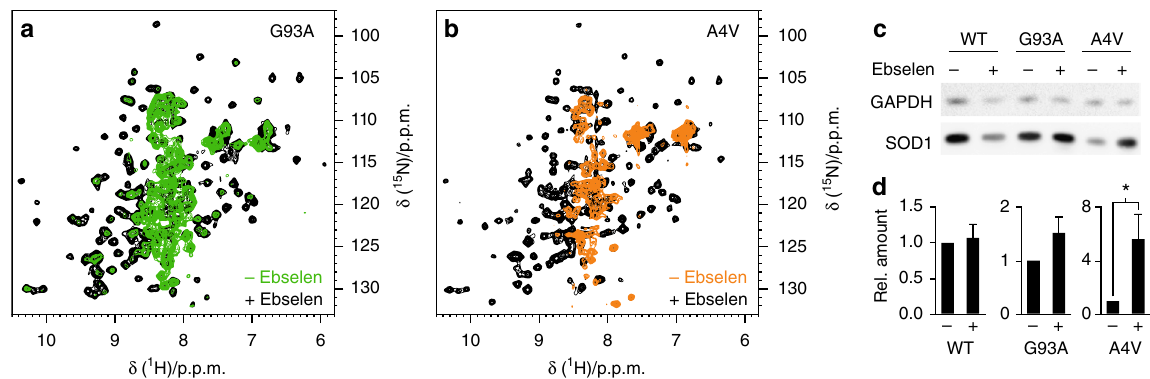
Fig. 5 Ebselen stabilizes ALS mutant SOD1 in living cells. a Overlay of 1 H- 15 N NMR spectra acquired on human cells expressing [U- 15 N] labelled SOD1 ALS mutants G93A ( a ) and A4V ( b ) in the absence (green/orange) and in the presence (black) of ebselen in the external medium. NMR signals clustered in the region around 8.3 p.p.m. ( 1 H) are characteristic of unstructured SOD1 species. c Western blot analysis of cell lysates expressing wild-type and mutant SOD1 in the absence and in the presence of ebselen. Original image Supplementary Fig. 11. d Expression levels of wild-type and mutant SOD1 in cell samples treated with ebselen relative to the corresponding untreated samples; error bars represent s.d. ( n = 3); * indicates signi fi cant differences (ratio t